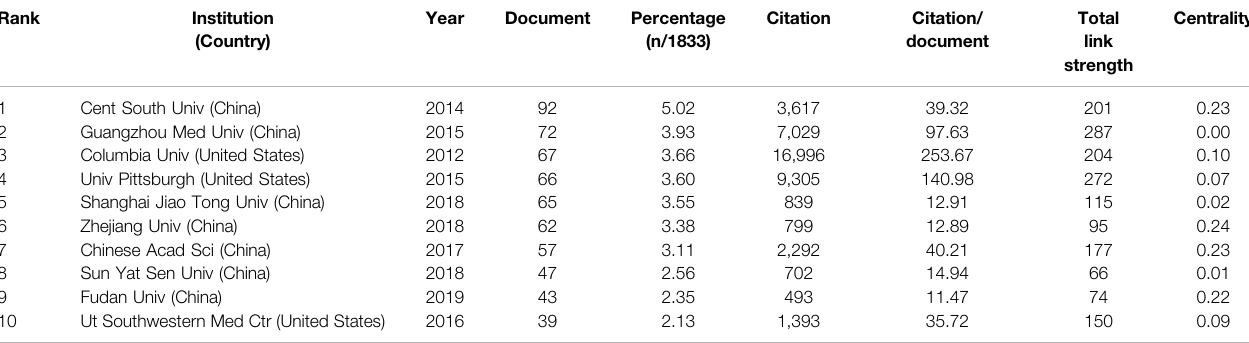
TABLE 3 | Top 10 institutions contributed to publications of ferroptosis in cancer.